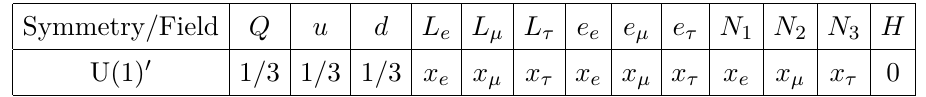
= 0 . 28 and σ = 0 . 25 α β